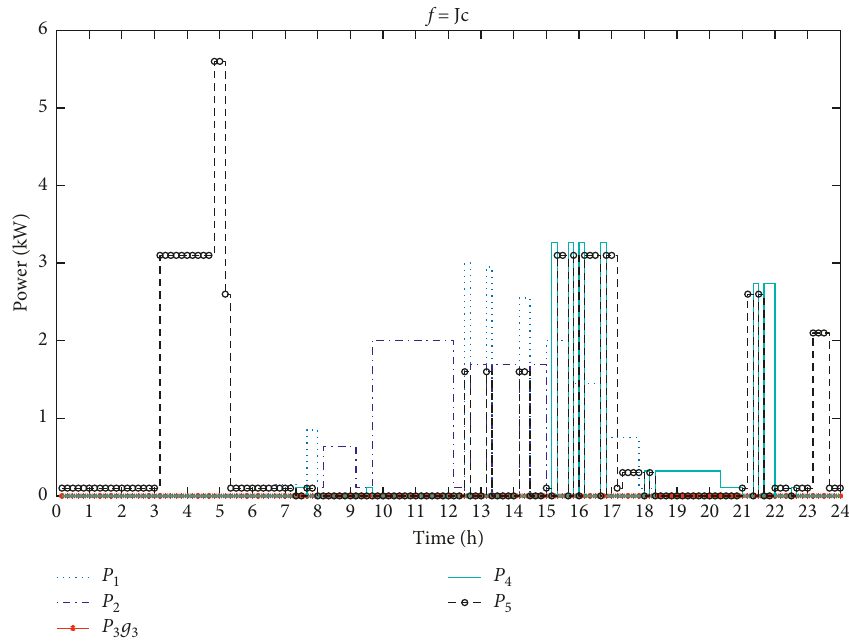
Figure 6: Power dispatch of the previous design in case